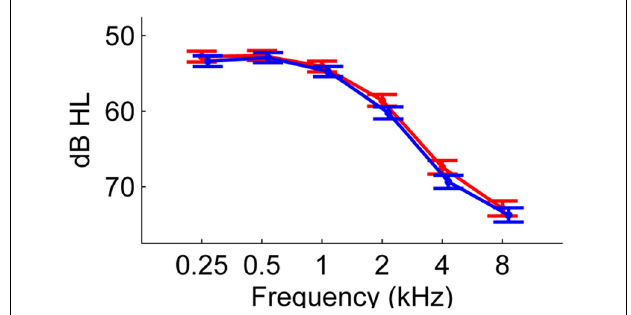
FIGURE 1 | Mean air-conduction PTA thresholds of 75 participants measured for right (red circles) and left (blue circles) ears. Error bars show ± 1 standard error of the